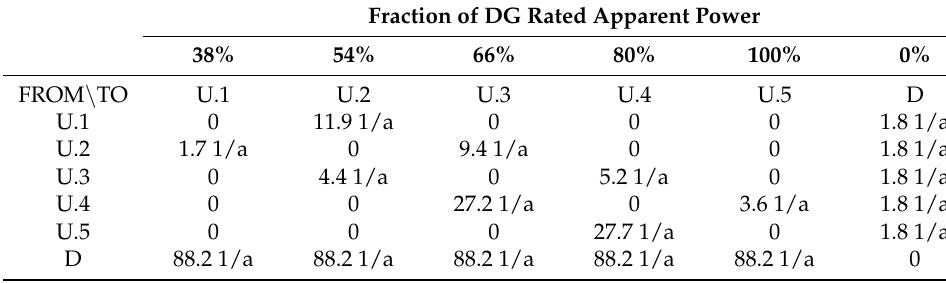
Table 5. Reliability parameters of SHPP [29].